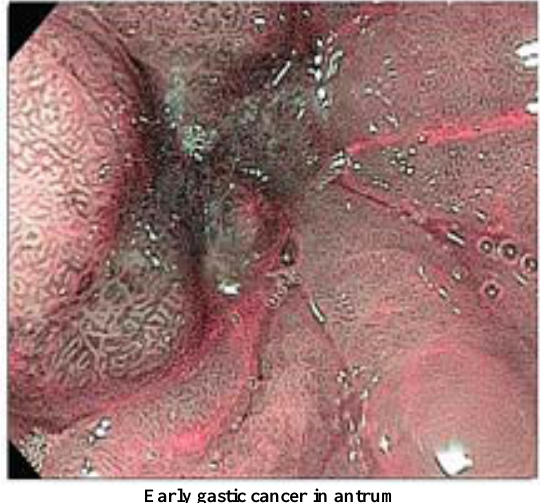
FIGURE 13. Stomach: early gastric cancer in the antral mucosa; narrow-band imaging without magnification. Depressed lesion type 0-IIa with intestinal metaplasia and an irregular pattern of epithelial